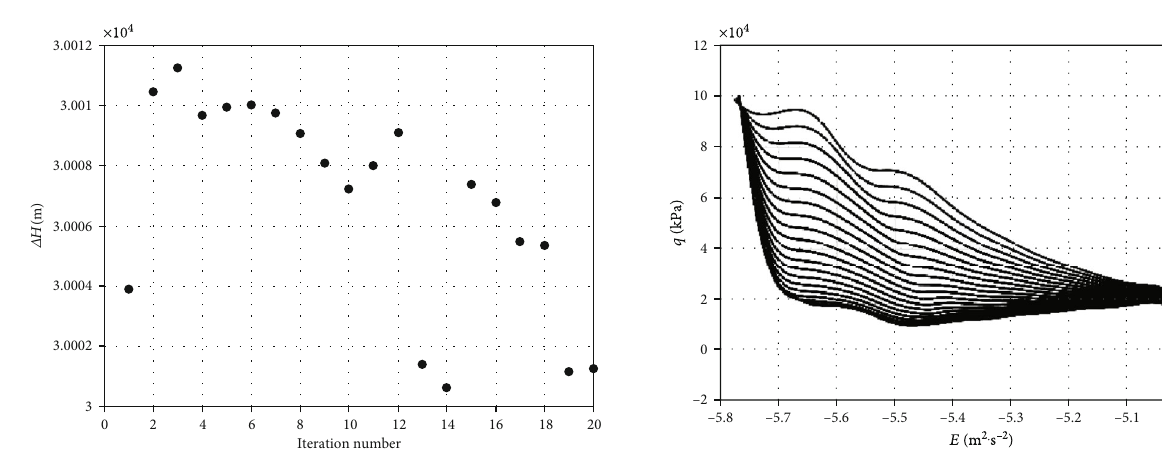
Figure 24: Dispersion of the terminal altitude.